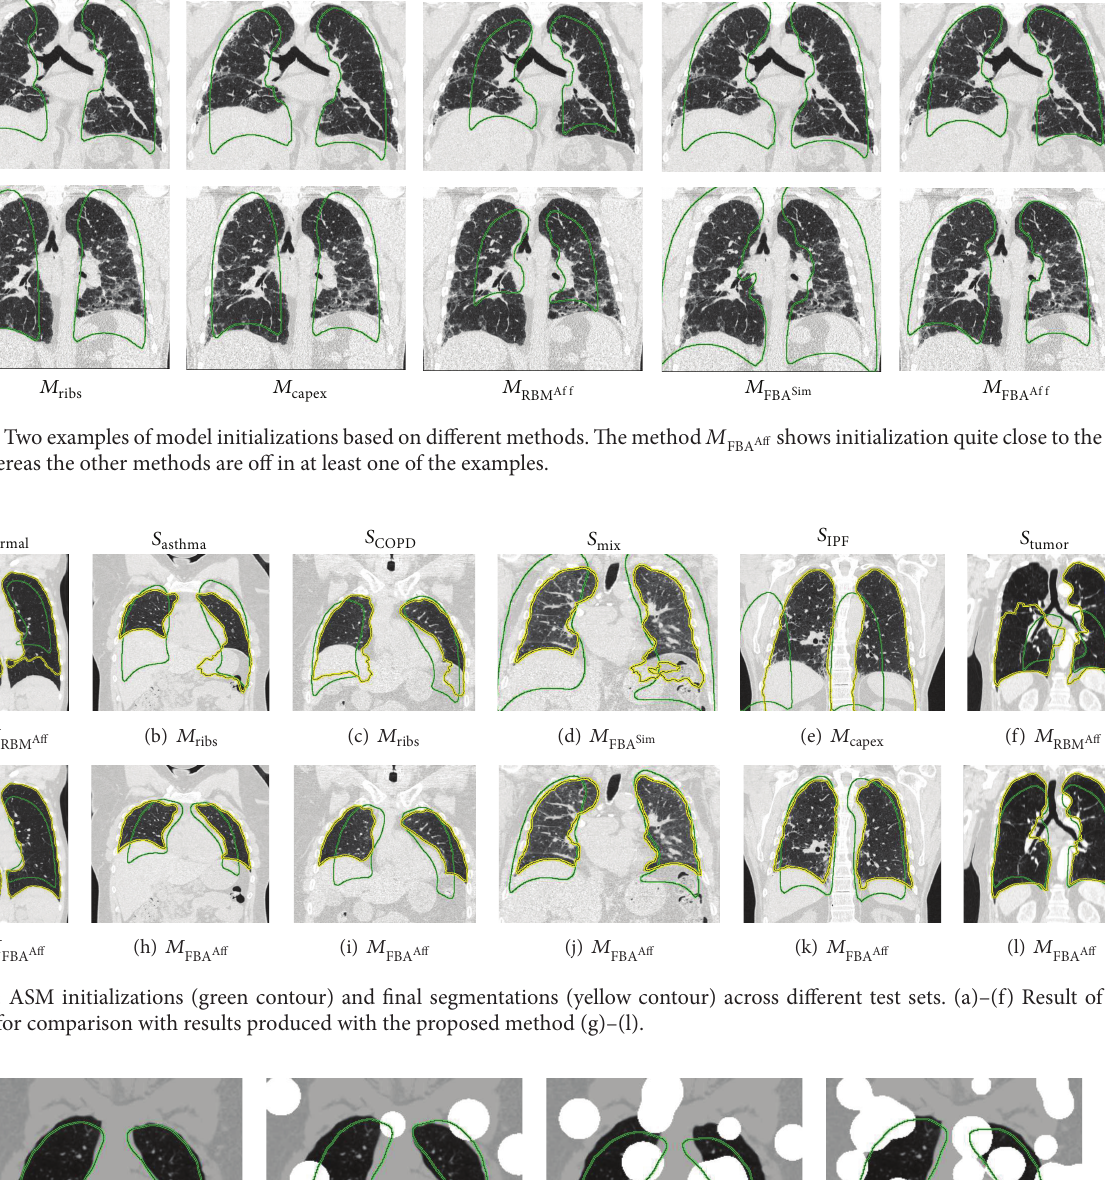
Figure 6: ASM initializations using 𝑀 on an image with varying degree of synthetic occlusion. The synthetic occlusion is generated by FBA Aff placing 𝑟 spheres, each of radius 25mm at random locations in the CT image. The voxels of the spheres are assigned a Hounsfield unit value of 500 HU. As can be seen, the method is robust to a large amount of